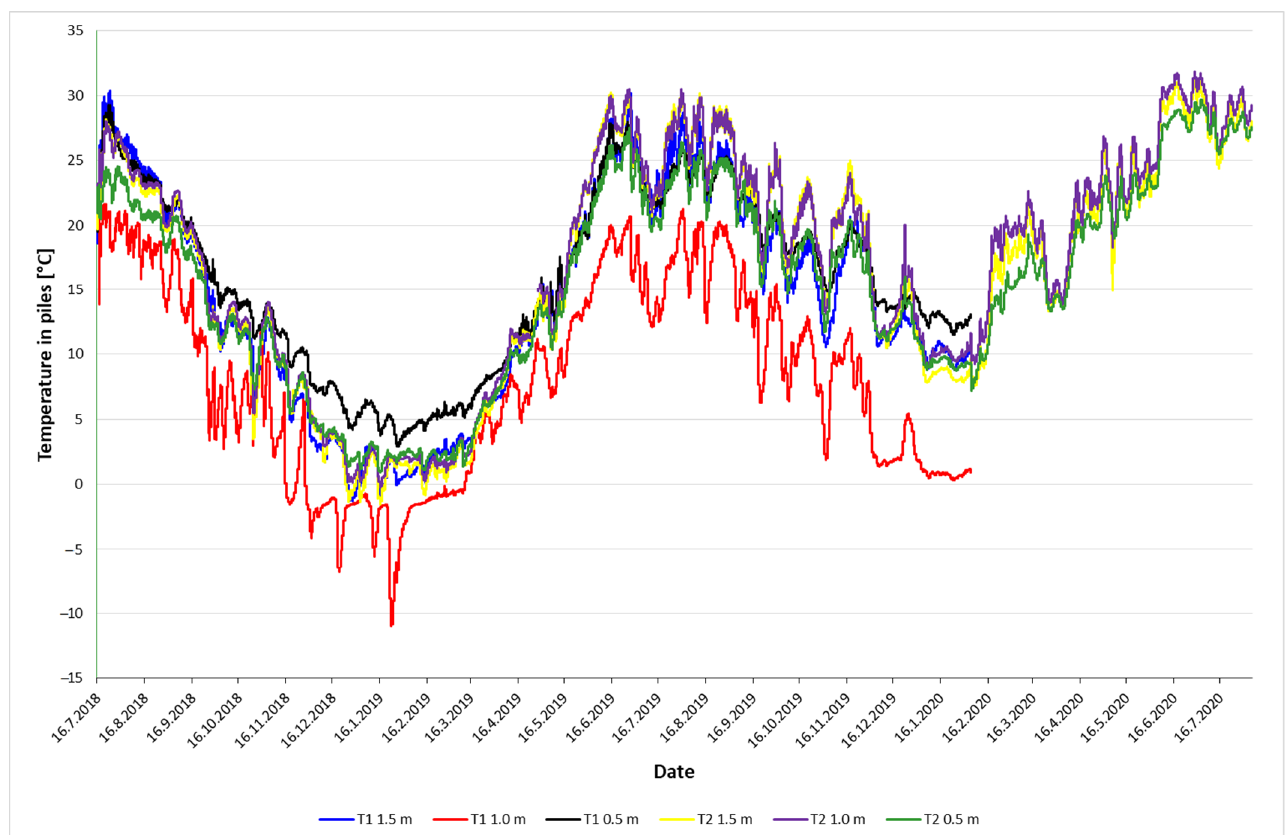
Figure 3. The temperature in the experimental piles during the storage period 2018–2020.